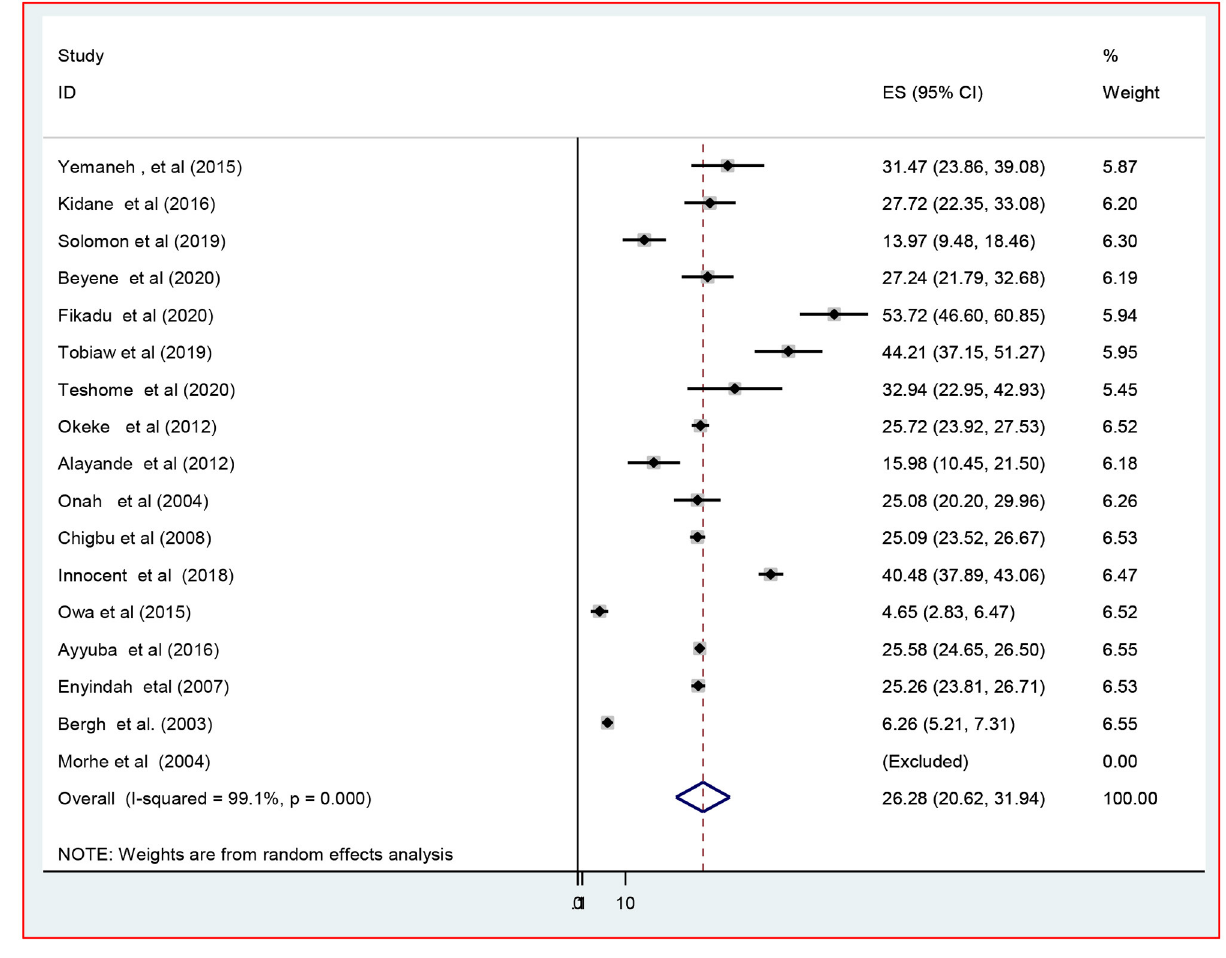
FIGURE 4 | The pooled prevalence of episiotomy practice among multiparous women in Africa,